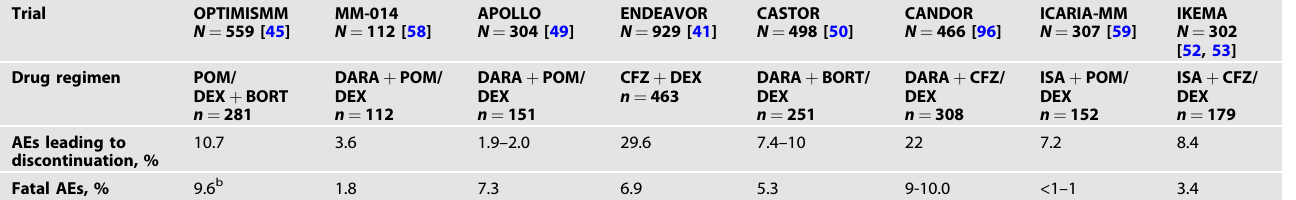
AE adverse event, BORT bortezomib, CFZ car fi lzomib, DARA daratumumab, DEX dexamethasone, ISA isatuximab, POM pomalidomide, RRMM